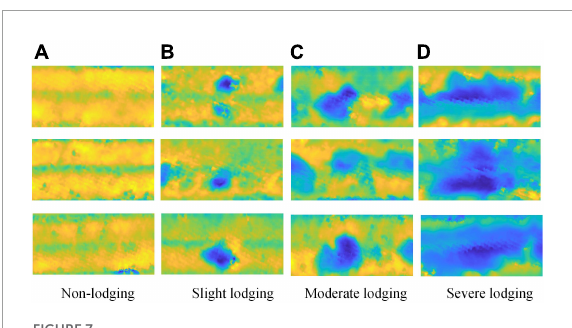
FIGURE7 The dataset for classification of wheat lodging. (A) non-lodging, (B) slight lodging, (C) moderate lodging, and (D) severe